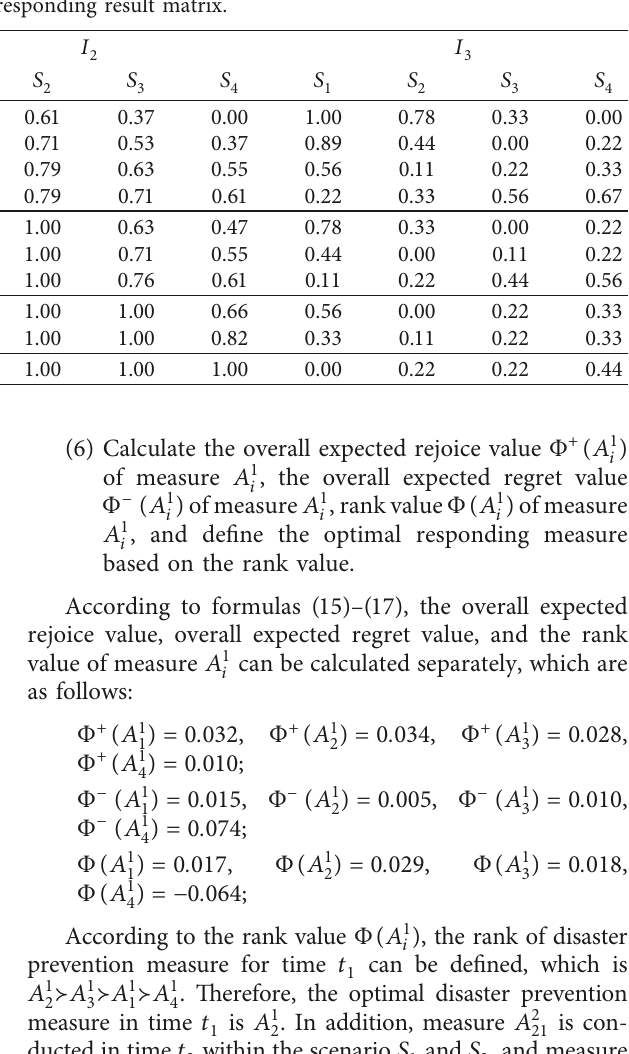
Table 2: Standardized responding result matrix.